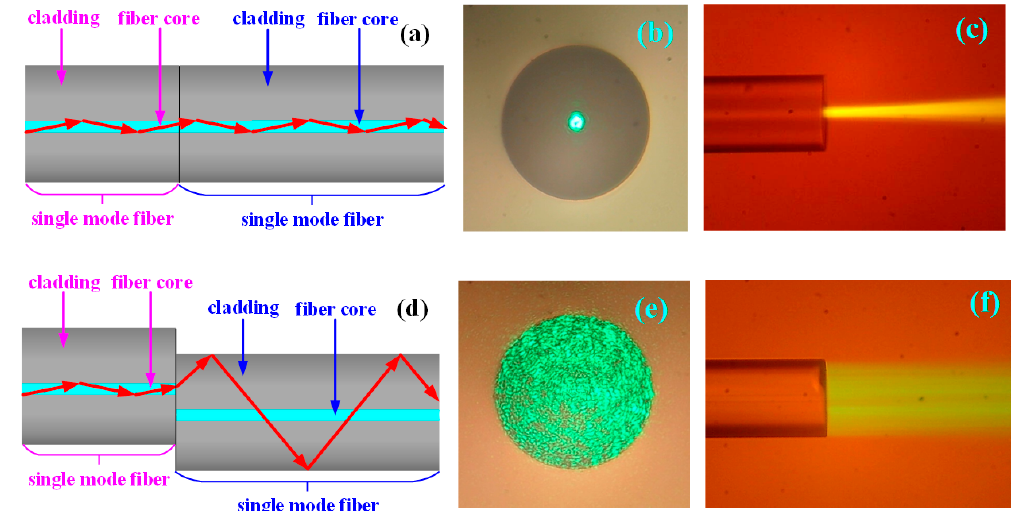
Figure 1. The investigation of the transmission of the light field of the single-mode fiber when normalized core welding and core-shift welding are used. ( a ) The schematic diagram of the single-mode fiber structure and light transmission when using normalized core welding. ( b ) Microphotograph of the light field from the end face of the single-mode fiber when normalized core welding is used. ( c ) Microphotograph of the light field from the side face of the single-mode fiber when using normalized core welding. ( d ) The schematic diagram of the single-mode fiber structure and light transmission when core-shift welding is used. ( e ) Microphotograph of the light field from the end face of the single-mode fiber when core-shift welding is used. ( f ) Microphotograph of the light field from the side face of the single-mode fiber when using core-shift welding.